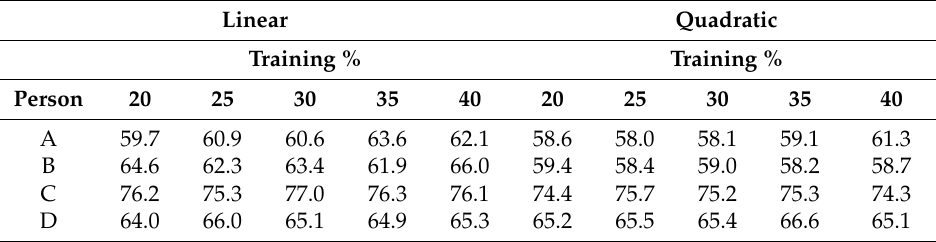
Table 2. Discriminant Analysis (DA) classifier results from each individual person.